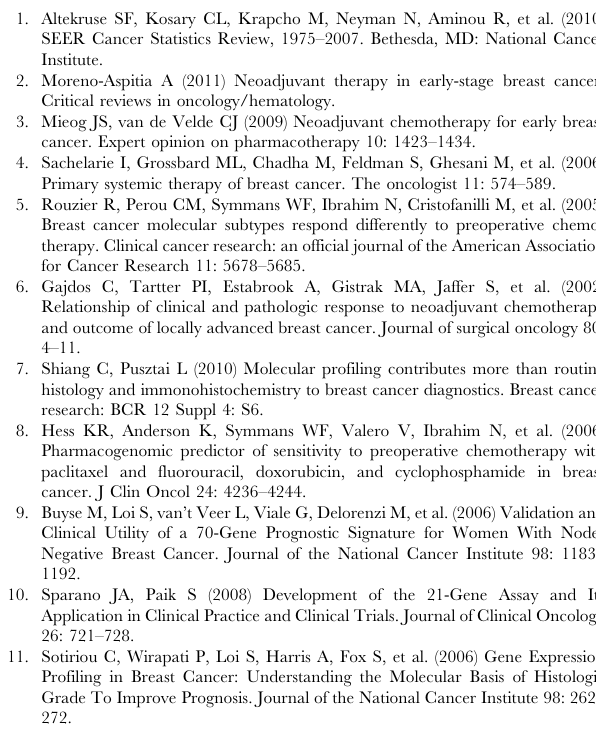
Table S1 Summary of chemosensitivity of 27 breast cancer cell lines to FEC and TFAC, and the information of gene expression measured by Neve and Hoeflich. Table S2 MGP-TFAC developed from the Neve training set by the superPC method. Table S3 MGP-FEC developed from the Neve training set by the superPC method. Table S4 MGP-TFAC developed from the Hoeflich training set by the superPC method. Table S5 MGP-FEC developed from the Hoeflich train- ing set by the superPC method. Table S6 MGP-TFAC developed from the Neve training set by the COXEN method. Table S7 MGP-FEC developed from the Neve training set by the COXEN method. Table S8 MGP-TFAC developed from the Hoeflich training set by the COXEN method. Table S9 MGP-FEC developed from the Hoeflich train- ing set by the COXEN method.